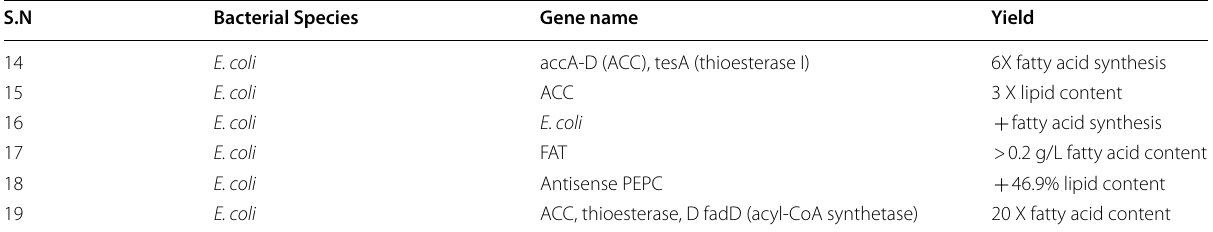
Table 5 List of various modified strain and their respective target gene or enzyme (Liang et al. 2013; Pfleger et al. 2015; Banerjee et al. 2017; Cho et al. 2018; Nie et al. 2022)